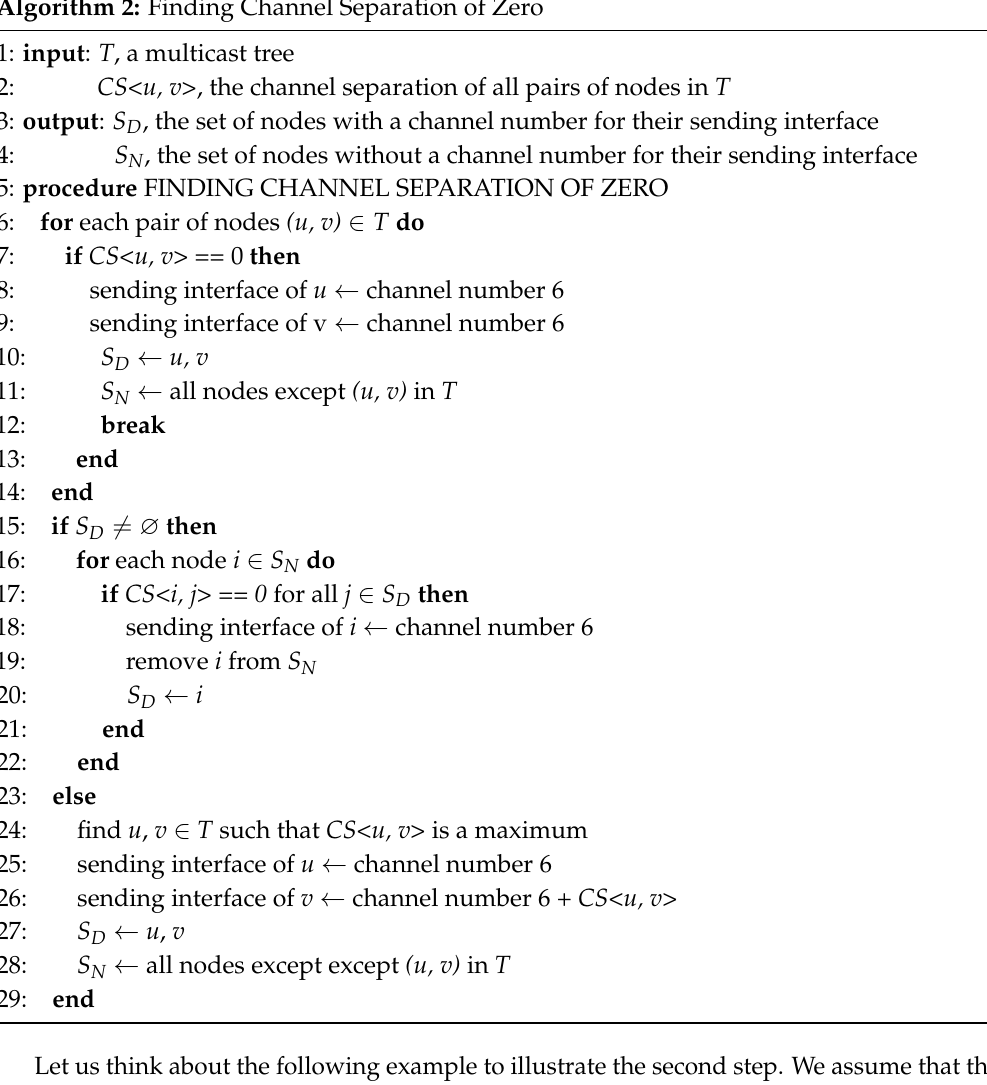
Algorithm 2: Finding Channel Separation of